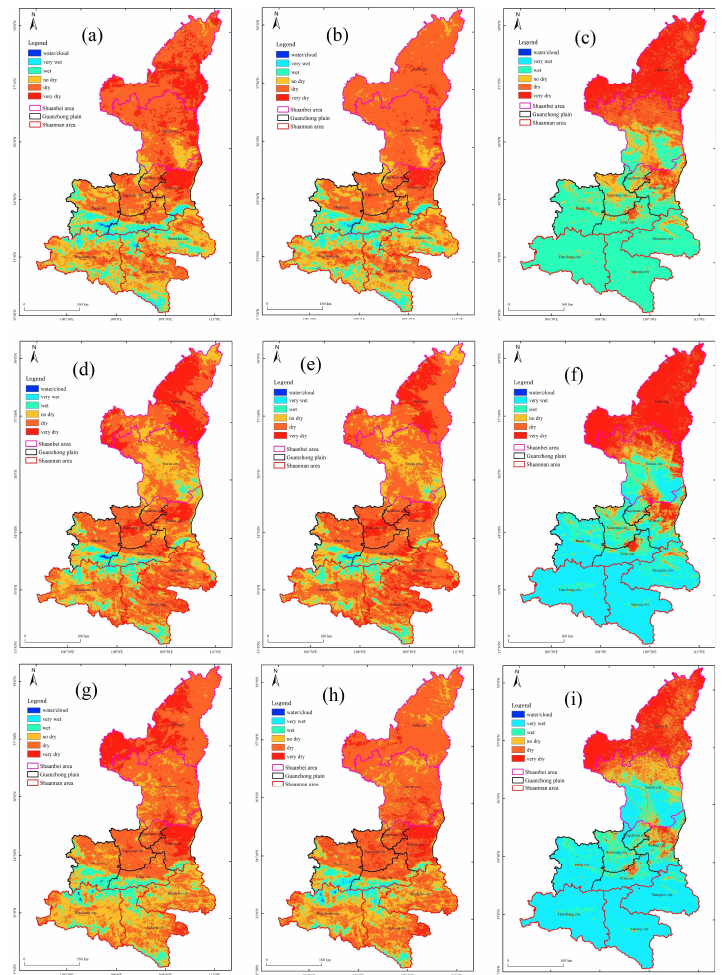
Figure 11. Comparison of drought conditions from TVDI c , TVDI t , and TVX, respectively. ( a )